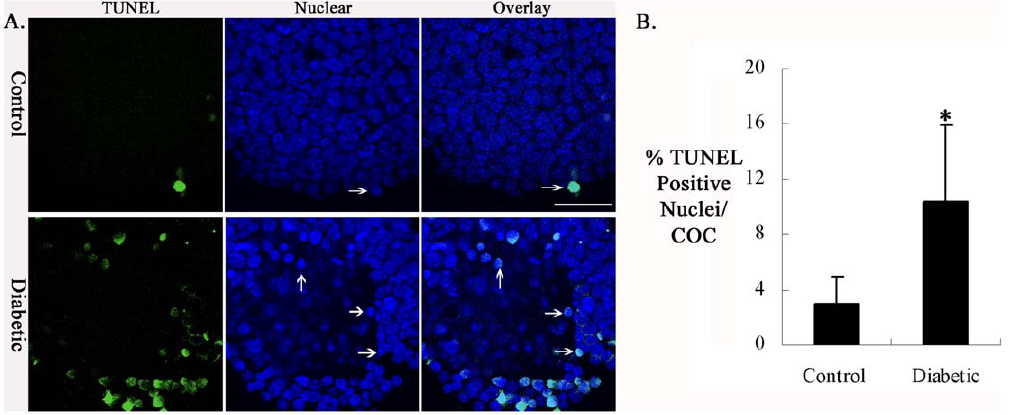
Figure 6. Increased apoptosis in cumulus cells of diabetic mice. (A) Cumulus-oocyte complexes from control and diabetic mice were stained with TUNEL to visualize apoptotic cells (green) and counterstained with DAPI to confirm nuclear status (blue). Arrows indicate the condensed nuclei of apoptotic cells. Representative confocal sections of cumulus cells are shown. (B) Frequency of TUNEL-positive nuclei in cumulus cells from control and diabetic mice. Data represent mean 6 SD of three independent experiments in which at least 30 COCs were analyzed. * p , 0.05 vs controls. Scale bar: 20 m m.